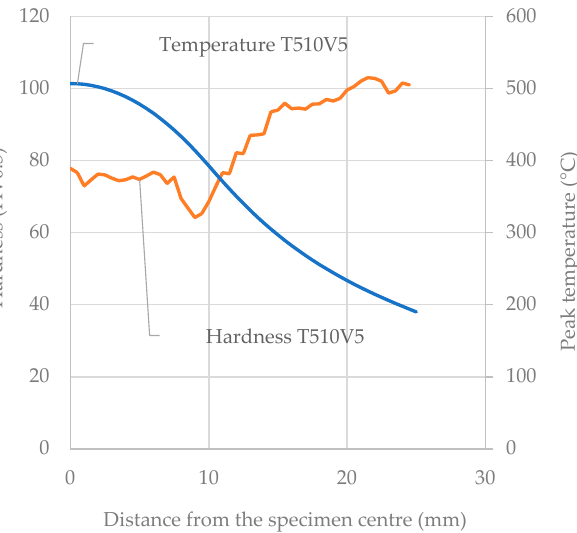
Figure 20. Hardness and peak temperature profiles relative to T510V5 test (T4 state).